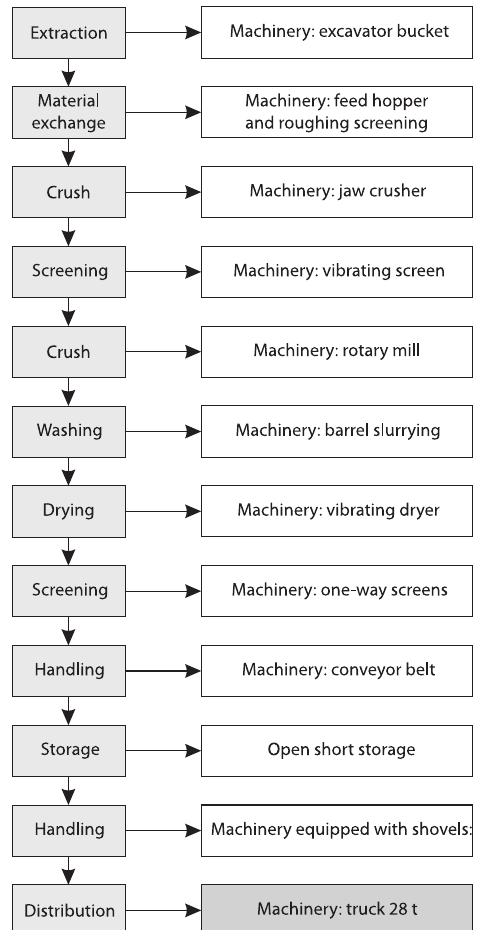
Fig. 1. Scheme of the production process of aggregate